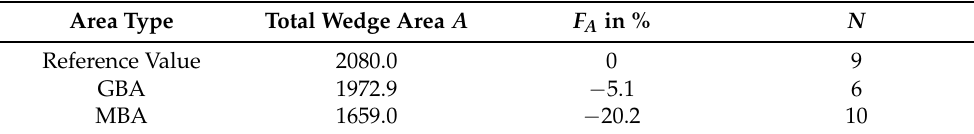
Figure 14. Thermogram of rotor blade of an in-service wind turbine with N = 9 turbulence wedges. ( a ) shows the preprocessed thermogram with the turbulence wedges numbered with roman numerals. ( b ) shows the reference transition line, which was estimated manually, as well as the CNR of the wedges noted above the respective wedge. ( c ) shows the result of applying the gradient-based algorithm (GBA) of Gleichauf et al. [14] to the image and ( d ) shows the result of the application of the model-based algorithm (MBA) on the thermogram. Note the reduced color scale, which makes the turbulence wedges more visible. Table 4. Areas determined by the model-based algorithm (MBA) as well as the state-of-the-art, gradient-based algorithm (GBA) for all turbulence wedges in Figure 13. The area values are given in unit pixel 2